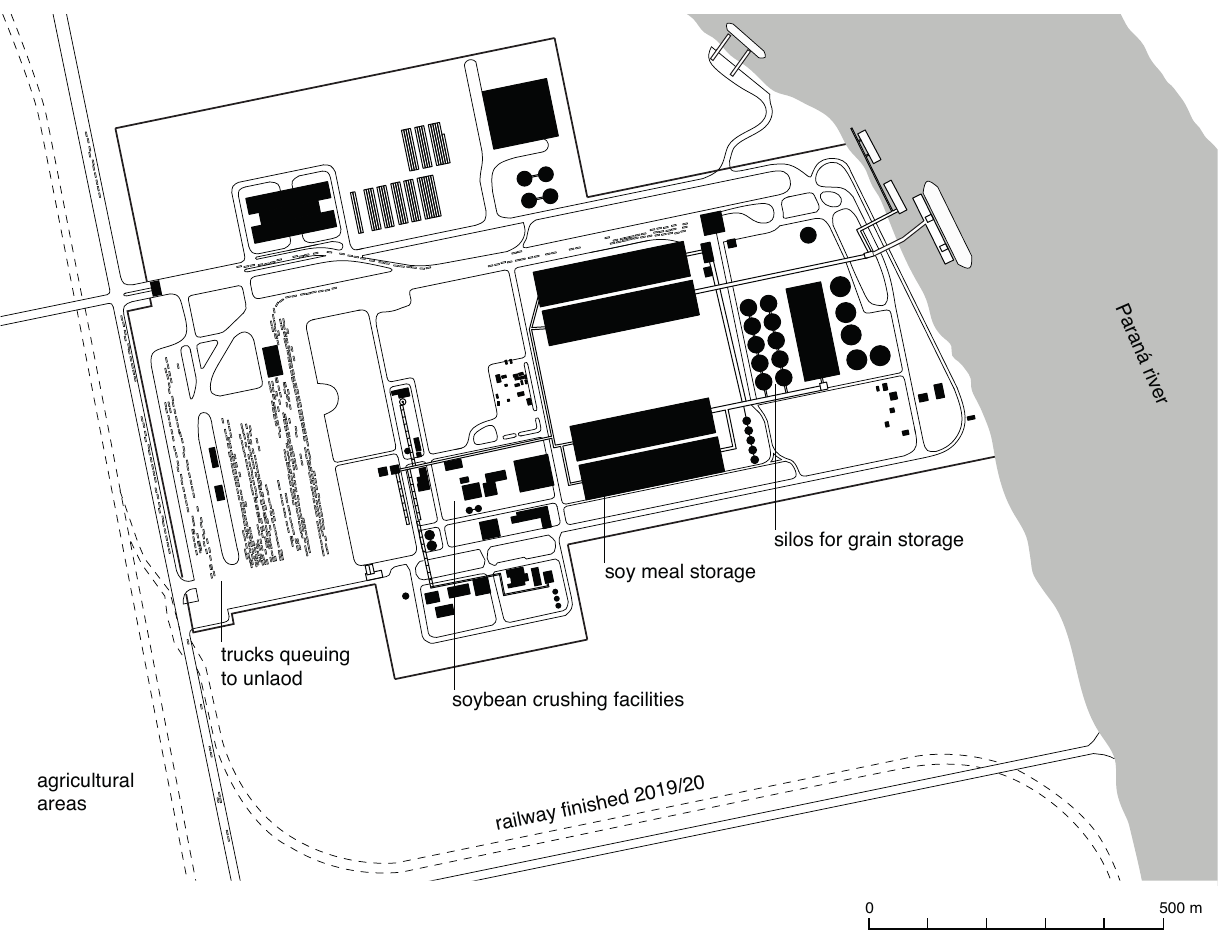
Figure 7. Soybean processing facility and China Oil and Foodstuffs Corporation harbour in Timbúes (2021). Sources: Authors based on Google Maps and